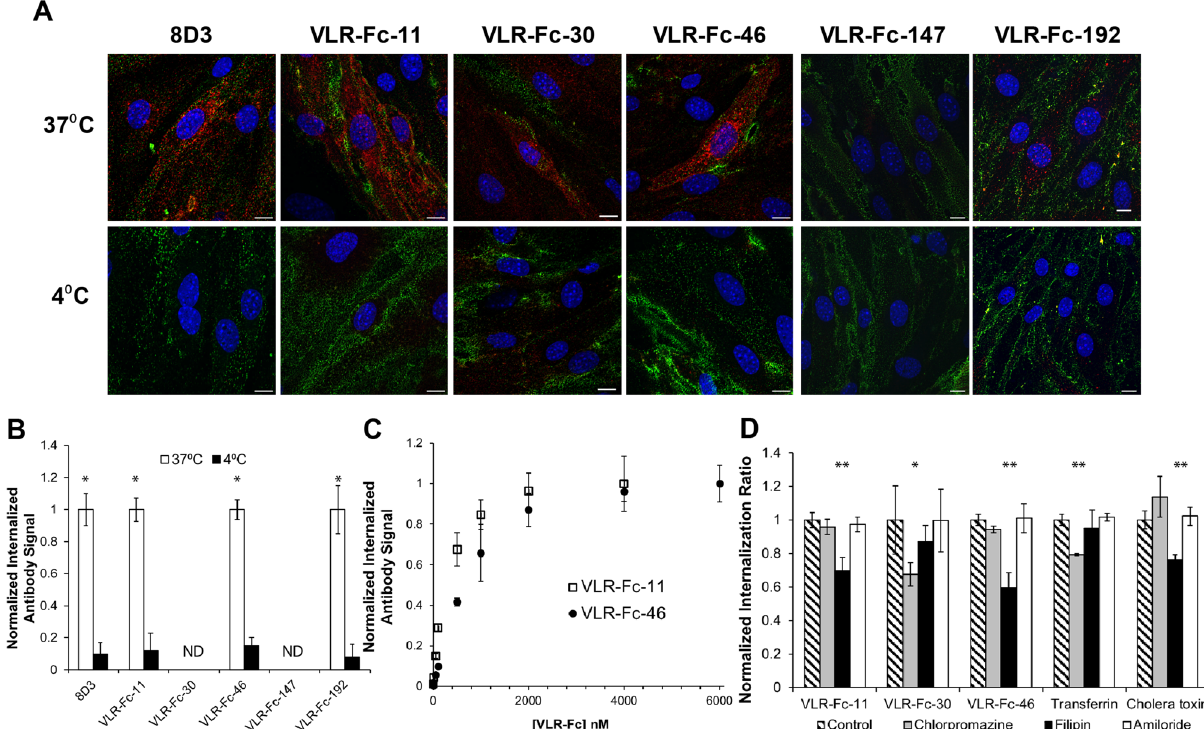
Figure 5. MBEC internalization of VLR-Fcs. ( A ) MBEC monolayers were incubated with either anti-TfR antibody (8D3) or the indicated VLR-Fc for 30 min at 37 °C or 4 °C. Surface bound (green) and internalized (red) antibody pools were differentially labeled. Representative confocal Z-slices are shown. DAPI (blue) was employed as a nuclear counterstain. Scale bars = 10 μm. ( B ) Per cell VLR-Fc internalization at 37 °C and 4 °C was quantified using a LiCor scanner and normalized to the 37 °C signal for each clone. ND = Not Detected. ( C ) Saturability of the internalization pathway was evaluated by titrating VLR-Fc concentrations and quantifying MBEC internalization as in ( B ). ( D ) Normalized ratio of internalized to surface bound VLR-Fcs in the presence of inhibitors of endocytosis pathways. For each sample, ratios were normalized to that of the filipin inhibition, respectively. Data in B, C, and D represent the mean ± S.D. of 3 independent internalization or saturation experiments ( B ). A two-tailed students t test on n = 3 replicates was used to determine